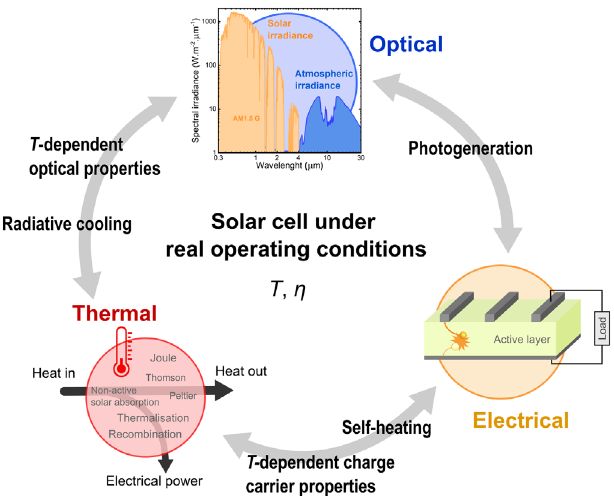
Fig. 1. The three physical modules and their main interconnec- tions that rule the behaviour of solar cells under real operating conditions. Solar absorption and radiative heat exchange with the atmosphere govern the photogeneration of charge carriers as well as radiative cooling, thus requiring a very broadband optical calculation. Heat generation in the solar cell is the result of self- heating mechanisms (Joule, Peltier, Thomson effect, non- radiative recombinations, thermalisation) as well as solar absorption in non-active regions. The temperature-dependent optical and electrical properties introduce an additional coupling between the different